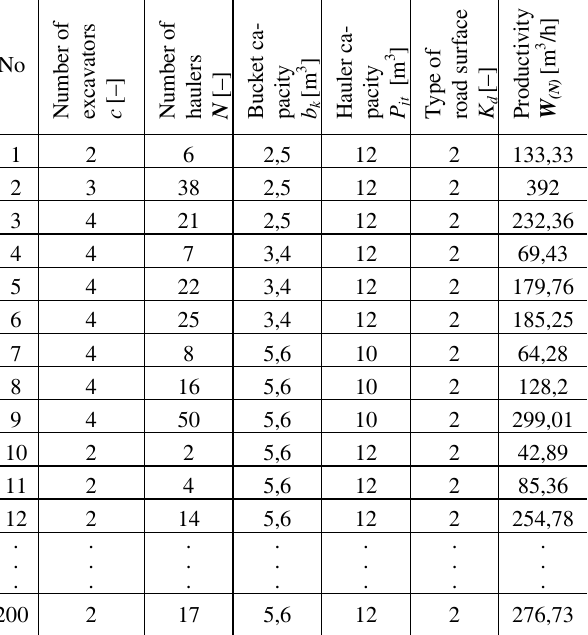
Table 1 . Exemplary values of parameters for predicting produc- tivity W (N),S for hauling distance of 2 km